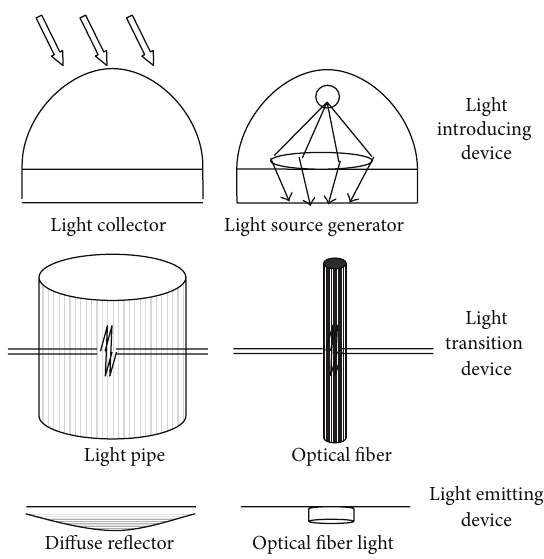
Figure 2: The composition diagram of natural light guidance sys-